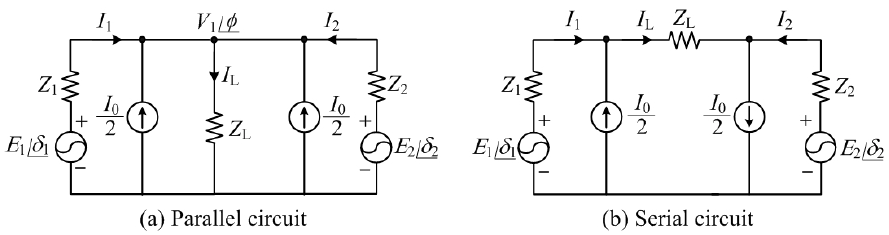
Figure 2. Serial and parallel circuits with two voltage and current sources. ( a ) Parallel circuit; and ( b ) serial circuit.